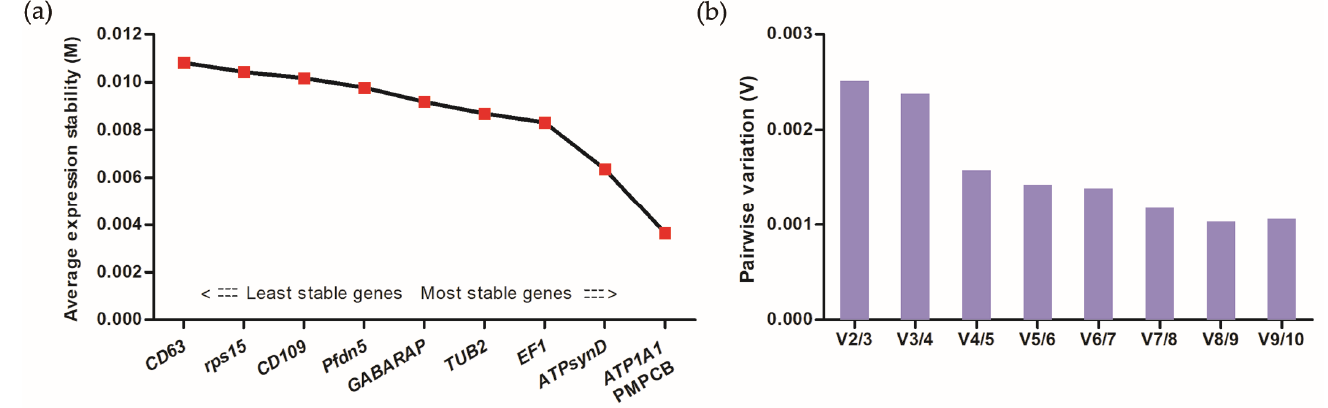
Figure 5. Stability of gene expression of ten core genes. ( a ) Ranking of the ten genes by geNorm. Left-hand side represents low stability; right hand-side represents high stability. ( b ) The optimal number of core genes for the normalization of gene expression was calculated by geNorm. Detailed information about these genes is given in Table S2.